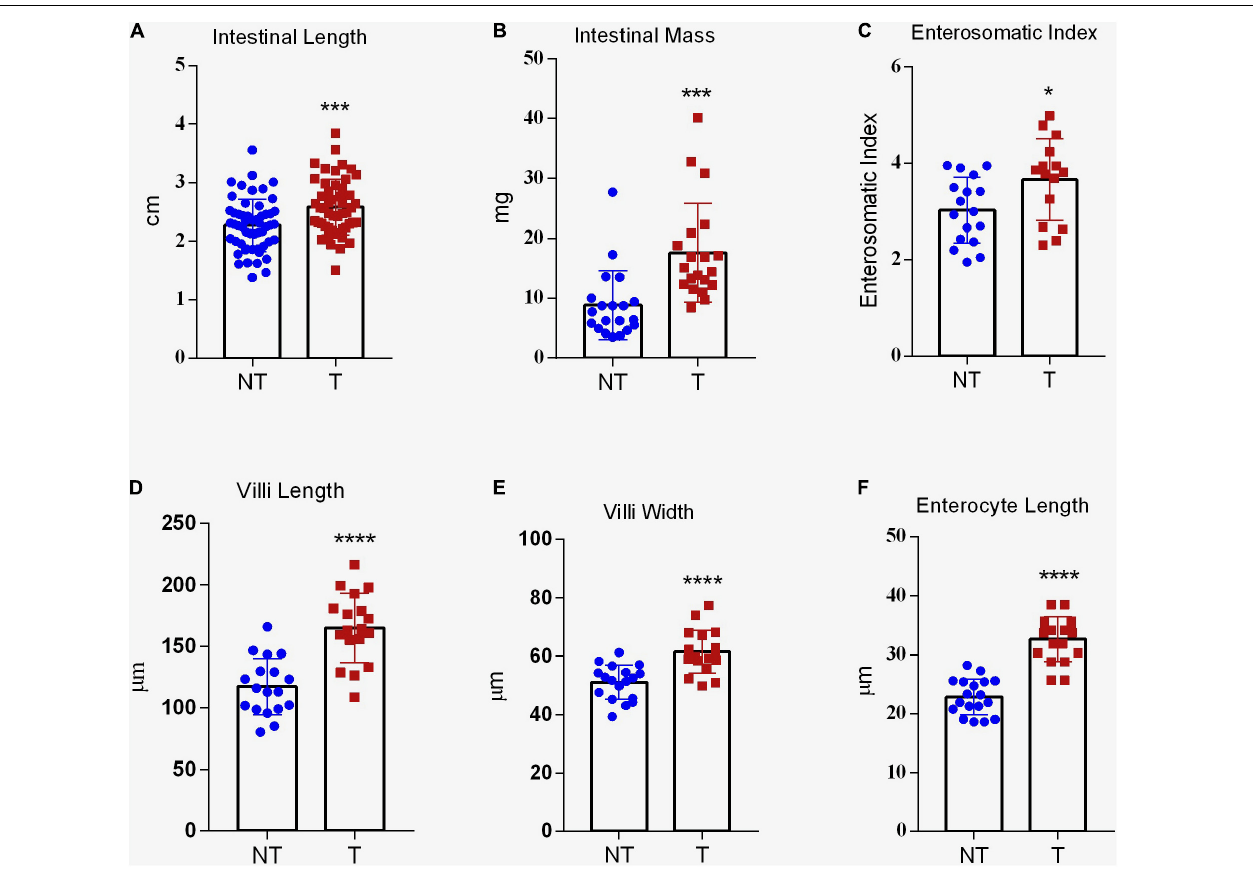
FIGURE 4 | Intestinal absorptive area of gh -transgenic zebrafish ( D. rerio ). Intestinal length (A) , intestinal mass (B) , and enterosomatic index (ESI) (C) were significantly increased in response to GH excess in transgenic zebrafish compared to non-transgenic full siblings. Data are shown as means ± SE of 37 fish per group. Gh -transgenic zebrafish show a significantly enhancement of villus height (D) , villus width (E) , and length of enterocyte (F) with respect to the control. Differences in all intestinal parameters between the two groups were determined using a two-tailed t -test. Data are shown as mean ± SE of 18 fish per group. Asterisks indicate significant differences ( ∗ p < 0.05; *** p < 0.001; and **** p < 0.0001). NT, non-transgenic; T, transgenic.